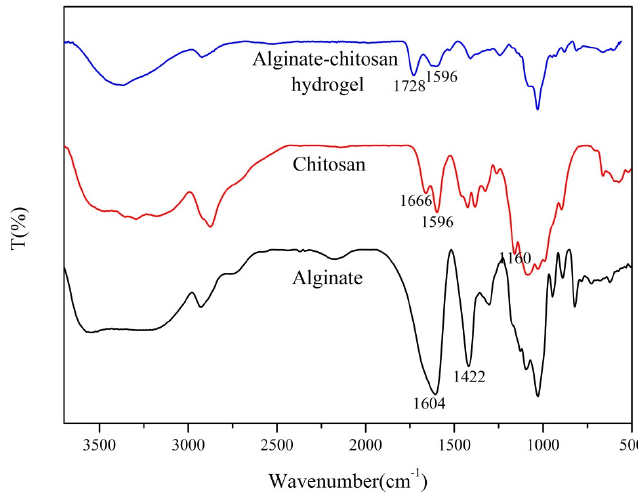
Figure 5. Fourier-transform infrared (FTIR) spectra of alginate and chitosan, and the 3D printed alginate–chitosan polyion complex hydrogels.